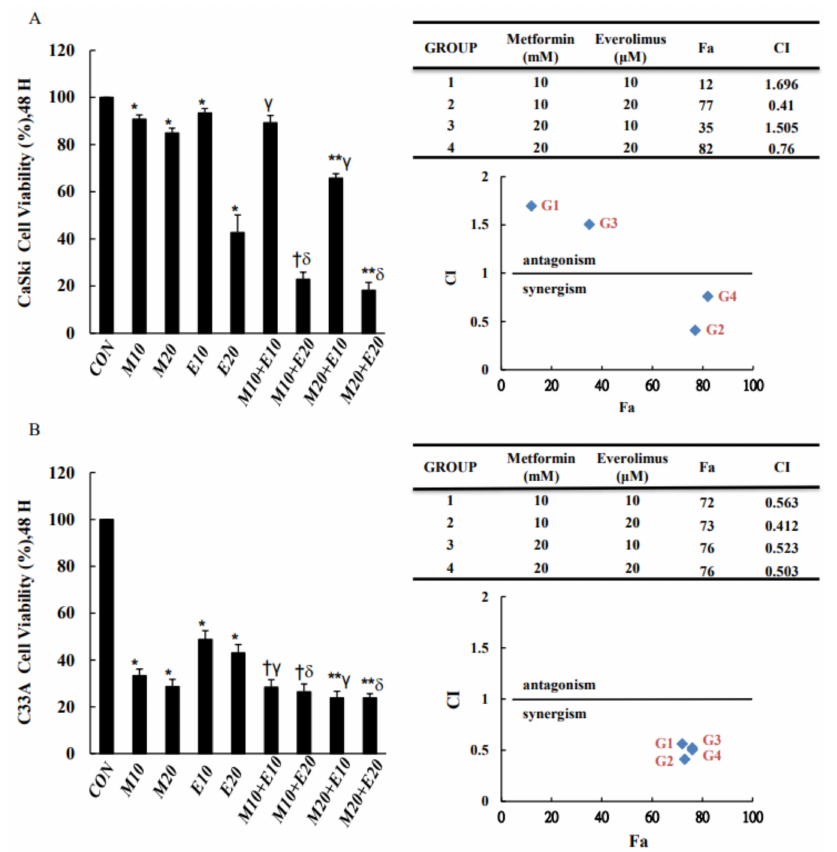
Figure 1. Metformin and everolimus inhibited CaSki and C33A cell growth. Inhibition effects of metformin (10, 20 mM) or everolimus (10, 20 µ M) on ( A ) CaSki and ( B ) C33A cell growth measured using a CCK-8 assay. Cells were exposed to metformin with or without everolimus for 48 h, then subjected to CCK-8 assay. CIs of metformin combined with everolimus were calculated using Chou– Talay analyses. Values represent the mean ± SD from three replicates. *, †, γ , ** and δ p < 0.05 compared with CON, Met 10- or Eve 10- or Met 20- or Eve 20-treated groups. CON, 0.1% DMSO; M10, 10 mM metformin; M20, 20 mM metformin; E10, 10 µ M everolimus; E20, 20 µ M everolimus. CI, combination index; Fa, affected